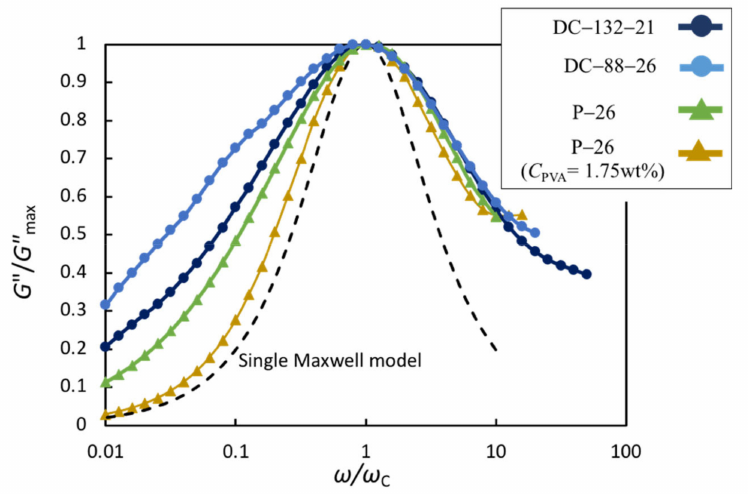
Figure 7. Comparison of the relaxation peaks of G (cid:48)(cid:48) for DC-132-21, DC-88-26, P-26 with C PVA = 12.0 wt% and P-26 with C PVA = 1.75 wt%. G (cid:48)(cid:48) and ω are reduced by G (cid:48)(cid:48) max and ω c for each specimen, respectively. The dashed line depicts the corresponding curve of a single Maxwell